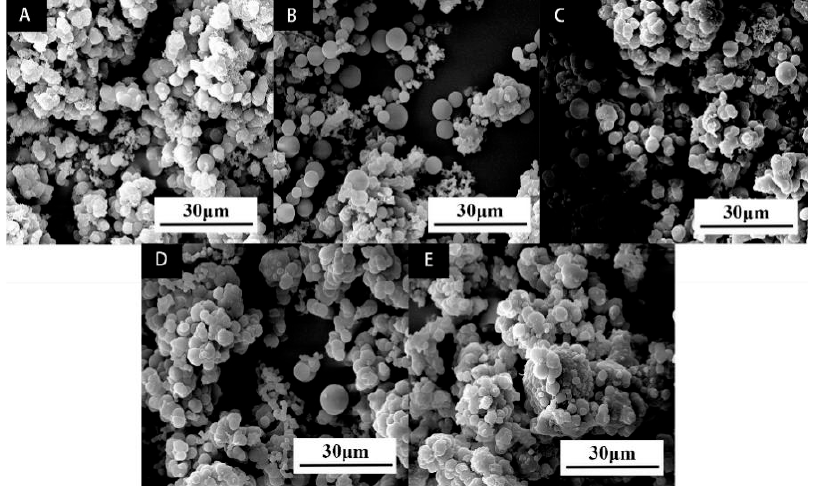
Figure 4. SEM morphology of single factor microcapsules: ( A ) rice husk powder content 0; ( B ) rice husk powder content 2.8%; ( C ) rice husk powder content 5.5%; ( D ) rice husk powder content 8.0%; ( E ) rice husk powder content 10.4%.